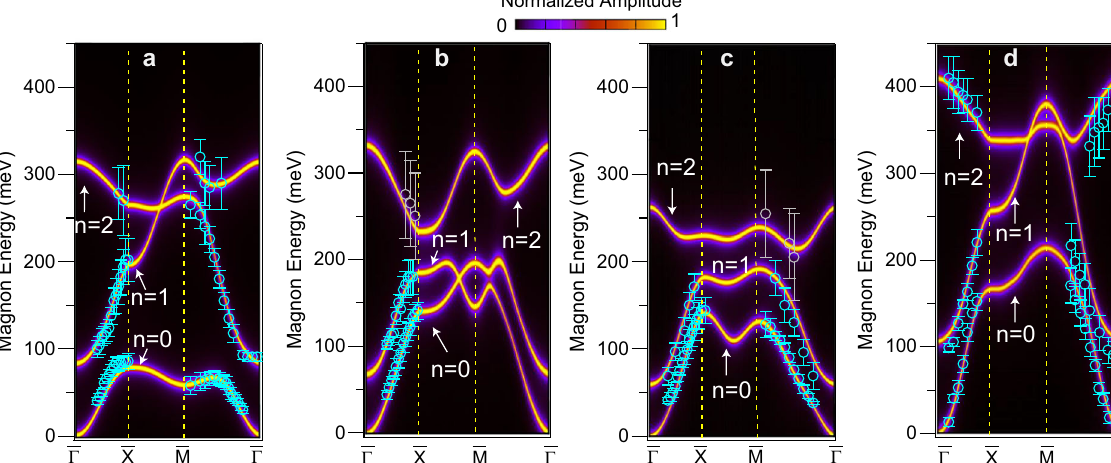
Fig. 2 The magnonic band structure of different layered structures. The results are presented for the a Co/Co/Fe, b Co/Fe/Co, c Fe/Co/Co, and d Co/ Co/Co systems. The calculated band structure is represented as the Bloch spectral function of magnons in all three layers. The experimental data are shown by symbols. The data shown by the cyan color are based on the analysis of the difference spectra. The data represented by the light-gray color are based on the analysis of the asymmetry spectra. While in the case of Co/Co/Fe the n = 0 and n = 1 magnon bands are very different in their shape, in the case of Co/Fe/Co they exhibit a rather similar shape. The error bars represent both the statistical and systematic uncertainties (see “ Methods ” section). In all panels, (cid:1) Γ , (cid:1) X, and (cid:1) M represent the high symmetry points of the surface Brillouin